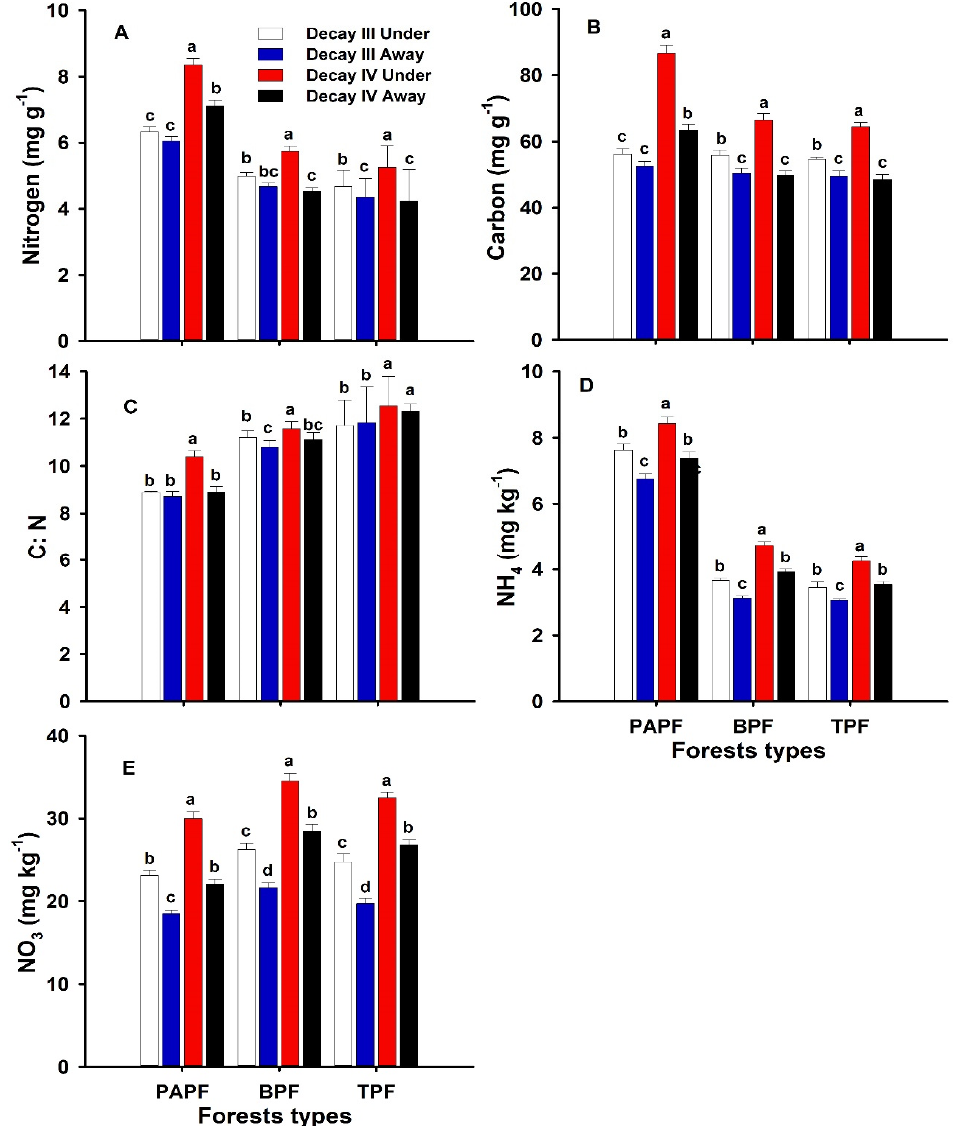
Figure 3. N (mg g − 1 ) ( A ), SOC (mg g − 1 ) ( B ), C:N ( C ), NH 4 -N (mg kg − 1 ) ( D ) and NO 3 -N (mg kg − 1 ) ( E ) concentrations of the same dominant tree species PK with different decay classes at different distances in contrasting forest types of PAPF, BPF and TPF in northeastern China. Significant changes between treatments within the same forest type are denoted by various lowercase letters. Tukey’s honest significant difference (HSD) post hoc; p < 0.05, mean ± SE = 3; the bars show standard errors. The C:N values of soil under different forest types, decaying class, distance from the decaying logs, as well as all possible interactions, was found significant. When averaged across DC and D, the TPF, with a mean value of 12.1 ± 0.6, had 8% higher values when compared to the BPF, and 24% higher values when compared to the PAPF, whereas the BPF, with a mean value of 11.2 ± 0.1, had approximately 18% higher values when compared to the PAPF. In the case of the decay classes, C:N was higher for DC-IV (11.1 ± 0.5) when compared to the less decomposed DC-III (10.5 ± 0.4) (Figure 3C). While comparing the distance from the decaying logs, the C:N values were higher under the CWD (11.1 ± 0.4) as that measured for higher distance, i.e., 50 cm away from deadwood with a mean value of 10.6 ± 0.5 mg g − 1 (11). Both decay classes for PAPF had significantly lower values for C:N, with a mean of 9.6 ± 0.3 for DC-IV and 8.8 ± 0.1 for DC-III. Similarly, for F × D,